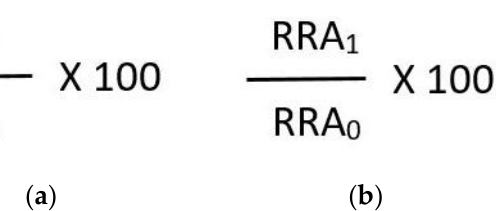
Figure 2. The measurement of RRA in a posterior root ( a ) at the end of REP, ( b ) at the 18-month follow-up. Complete healing and apical closure are observed.